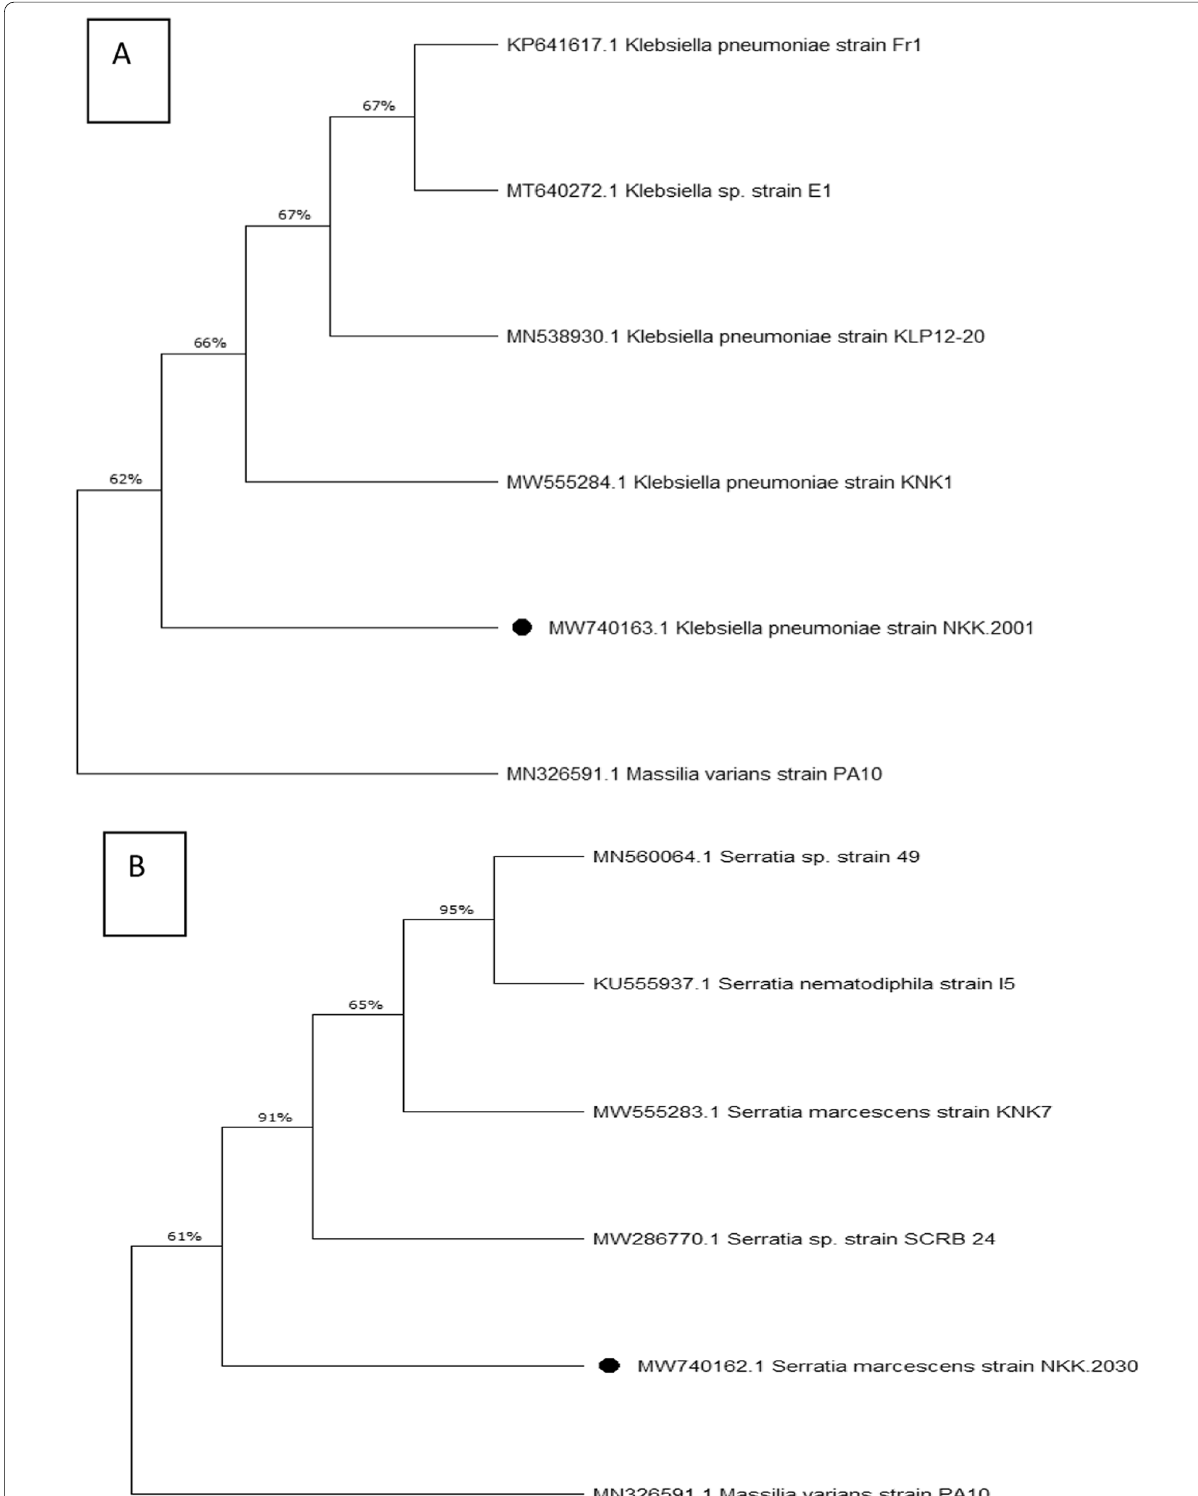
Fig. 1 Maximum likelihood phylogenetic tree‑based ribosomal region 16s‑rRNA and bootstrap support values > 60 (BS) are given at the nodes (BS) on 16s‑rRNA sequences of rDNA of Klebsiella pneumoniae isolate (MW740163.1, Fig. A ) , Serratia marcescens isolate (MW740162.1, Fig. B ), and Bacillus thuringiensis isolate (MT487672.1, Fig. C ) aligned with closely related sequences accessed from the GenBank. The marker reflects the relative phylogenetic distance